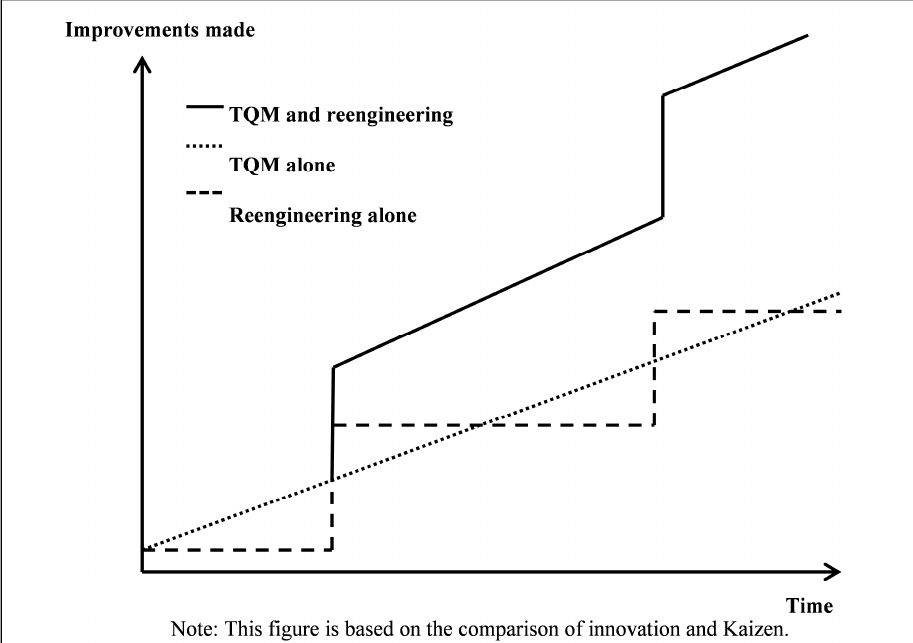
Figure 1 - Advantages of applying TQM and reengineering jointly (Lorente,